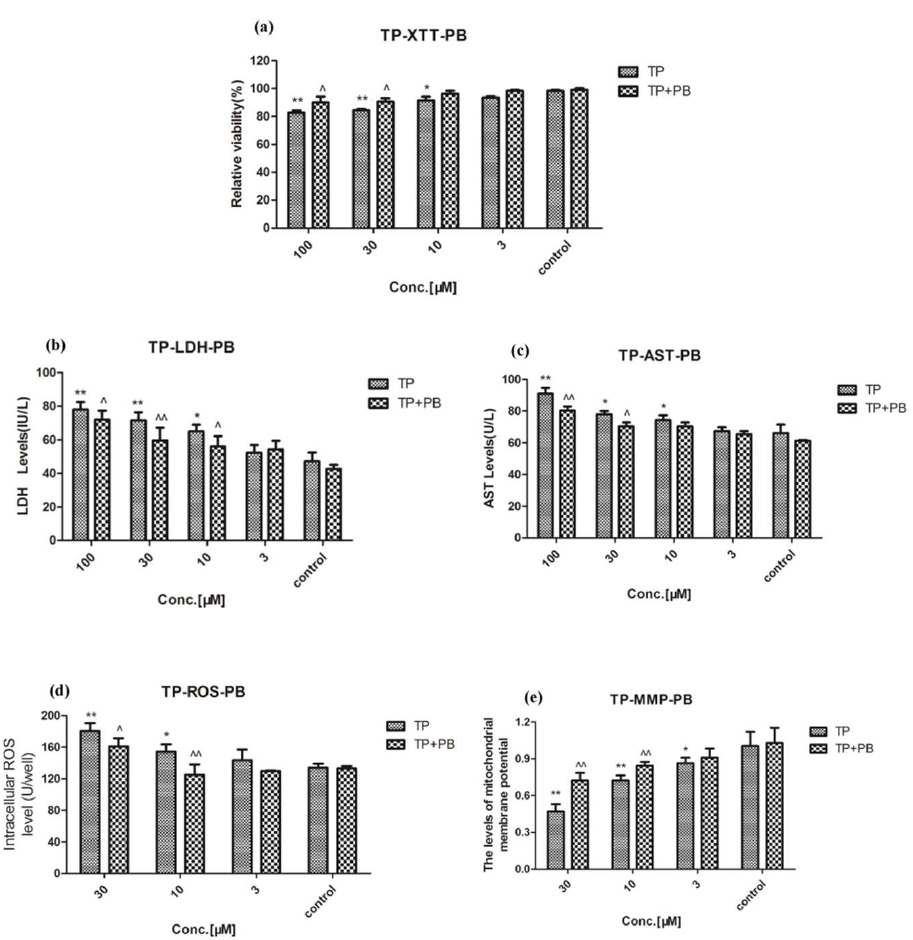
Figure 7. The influence of triptolide on cells after PB was treated at 40 mg / kg for five days. ( A ) Relative viability after treatment with a variety of concentrations of triptolide. ( B ), ( C ), ( D ) Cellular LDH, AST, and ROS accumulations in treatment with primary rat hepatocytes, respectively. ( E ) The MMP after treatment with different concentrations of triptolide. Compared with the control group, * p < 0.05, ** p < 0.01; compared with triptolide group, ^ p < 0.05, ^^ p < 0.01.